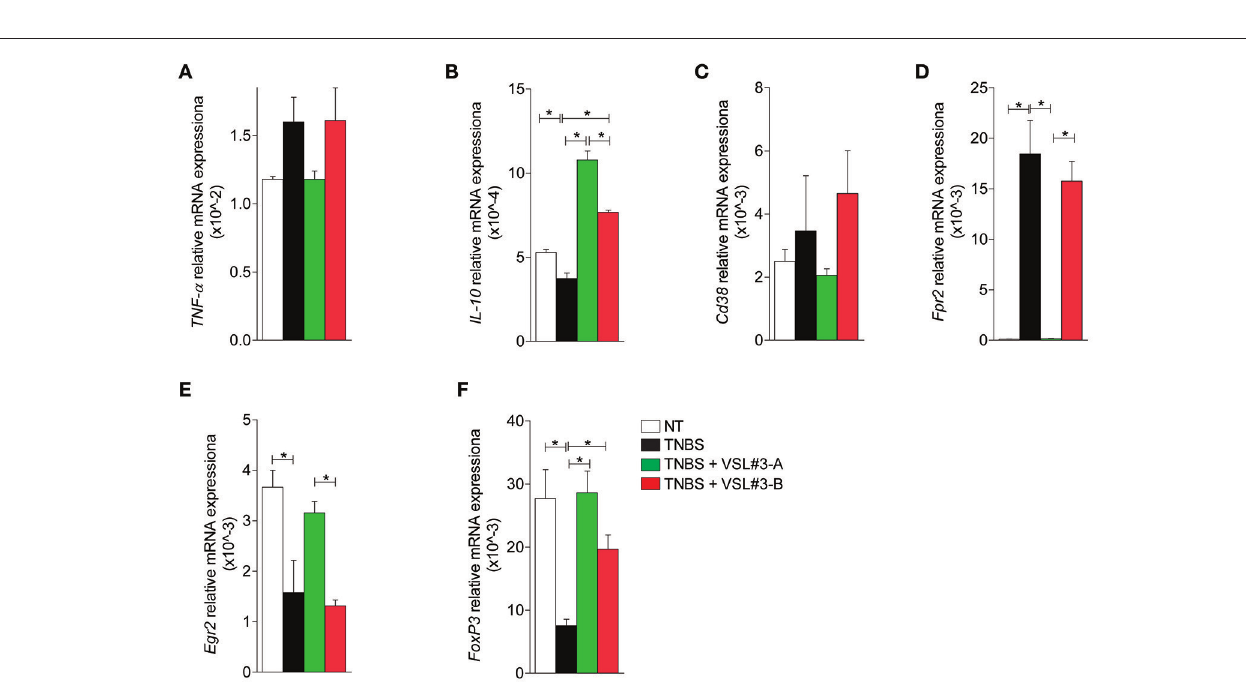
FIGURE 4 | Effects of two VSL#3 preparations on biomarkers of intestinal inflammation in the TNBS colitis. Quantitative rtPCR analysis on mesenteric lymph nodes: pro-inflammatory cytokine TNF- α (A) , anti-inflammatory cytokine IL10 (B) , M1 macrophage markers Cd38 and Fpr2, (C,D) , M2 macrophage marker Egr2 (E) , and Treg cells marker FoxP3 (F) . Results are the mean ± SEM of 3–5 mice per group (* P < 0.05).